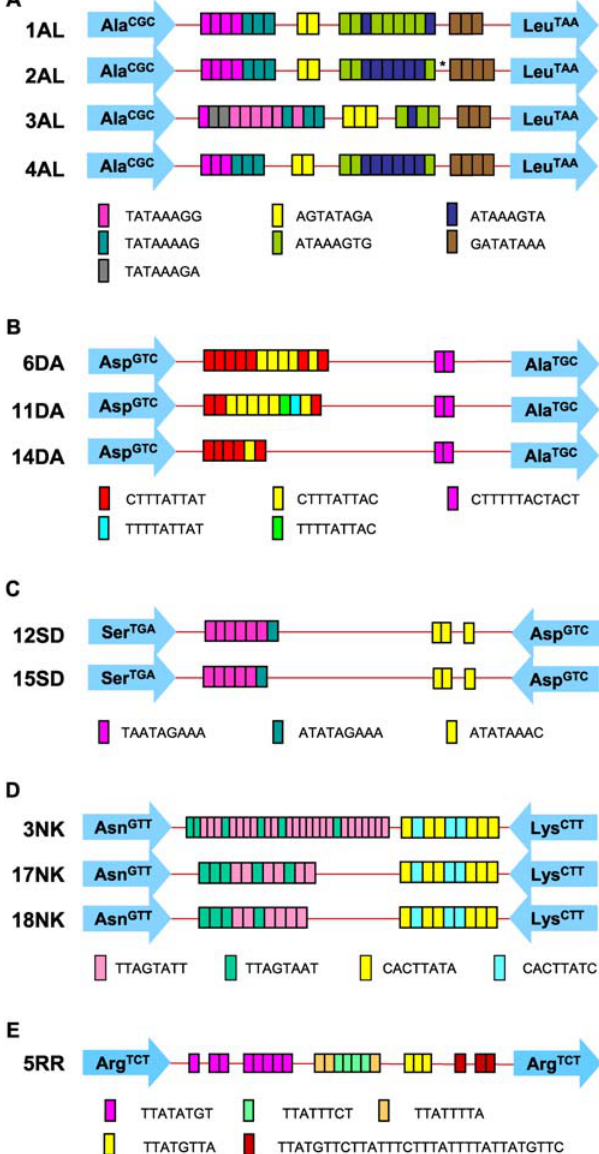
Figure 2. Sequence types of PCR products from paired samples. Schematic representations of (A) locus A-L, (B) locus D-A, (C) locus S TGA -D, (D) locus N-K2 and (E) locus R-R are given to illustrate the sequence type differences observed between paired samples. The asterisk indicates a single base insertion of A in the 2AL sequence. Each arrow represents a specific tRNA gene (shown inside the arrow) and colored boxes represent the STRs. The sequence types in loci N-K2, R-R, and S TGA -D were according to reference 13 (EF427346-EF427363, EF421375-EF421386 and EF421387-EF421403, respectively), and locus D-A sequence types were according to Clark, Ali and Haque (EU251498– EU251501 and unpublished). 5 sequence types have been detected to date in locus A-L